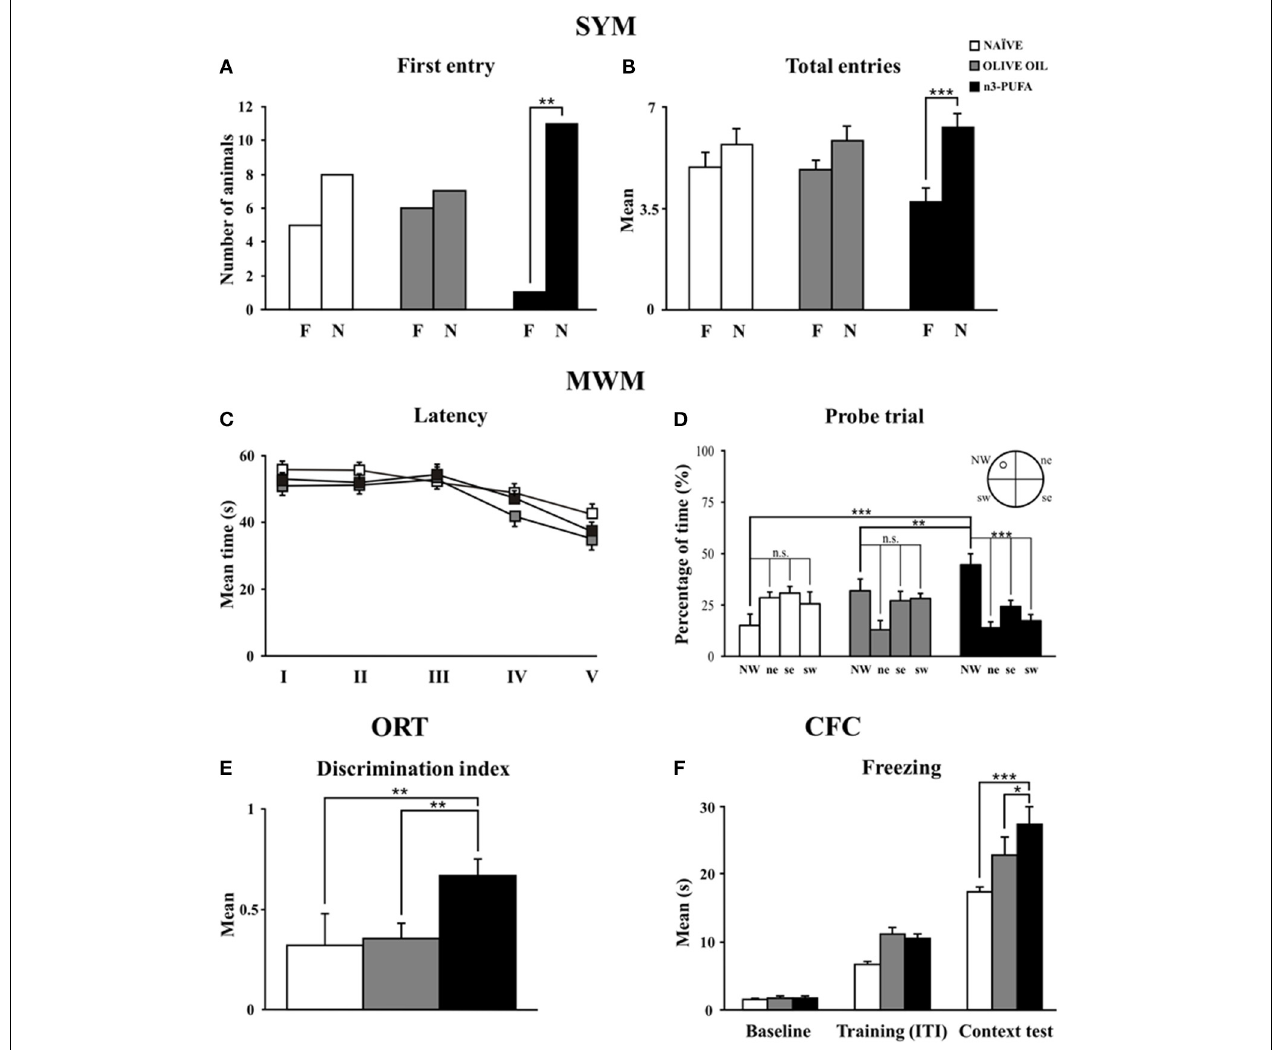
FIGURE 2 | n-3 PUFA effects on behavioral performances. (A,B) First entry (A) and total entries (B) in the familiar (F) and novel (N) arm displayed by the three experimental groups in Spatial Y-Maze (SYM). (C,D) Mean escape latency to reach the hidden platform during Place phase of Morris Water Maze (MWM) (C) and time spent in the rewarded quadrant during Probe trial